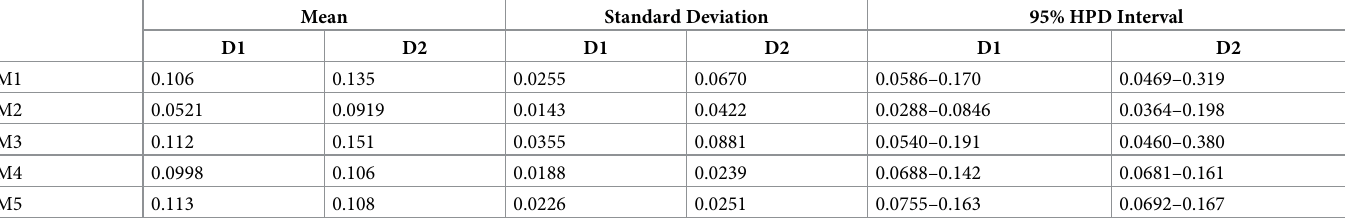
Table 2. Posterior means, posterior standard deviations and the 95% highest posterior density interval (HPD) of the genetic variance (true value = 0.1) under differ- ent models 1 and datasets 2